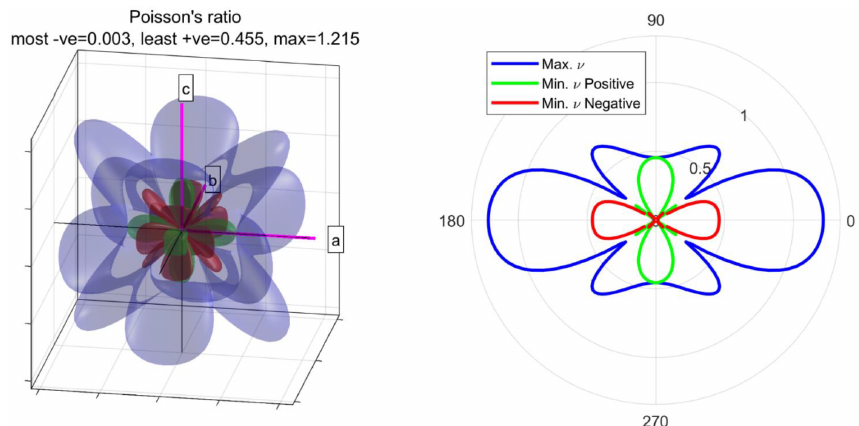
Figure A4. Benchmarks to Marmier et al. (2010, their Figs. 5 and 6) for cubic cesium. Note the auxetic nature of Poisson’s ratio.